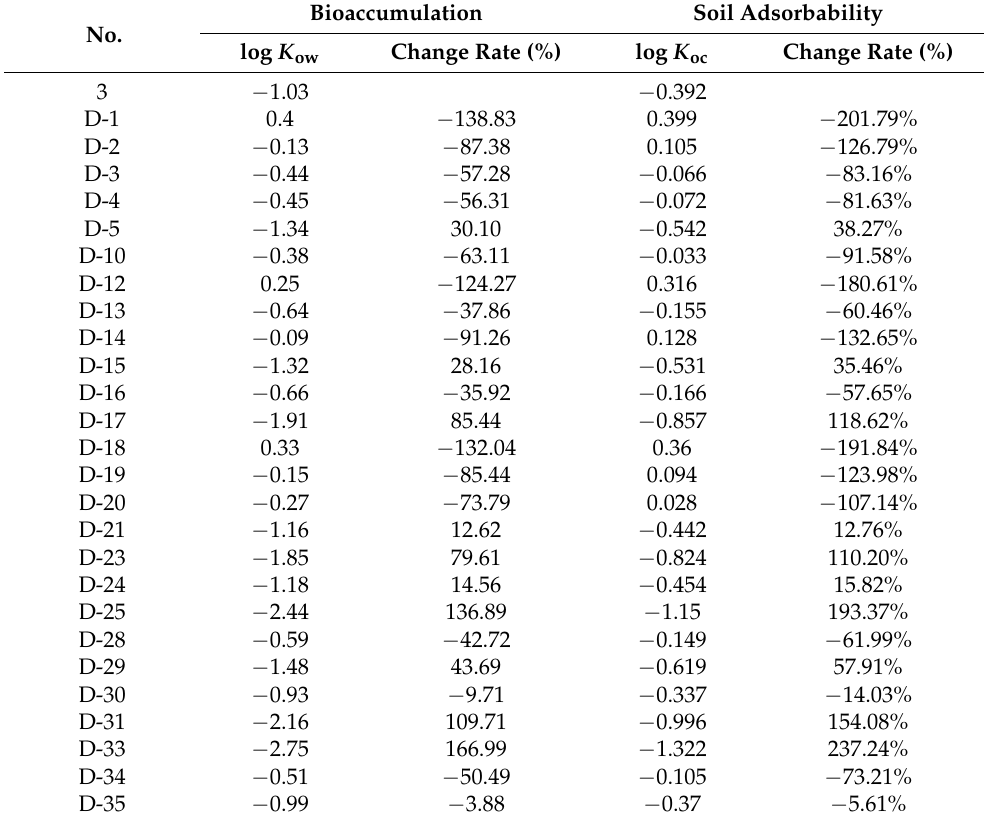
Table 5. Evaluation of the environment-friendliness of NOR and its